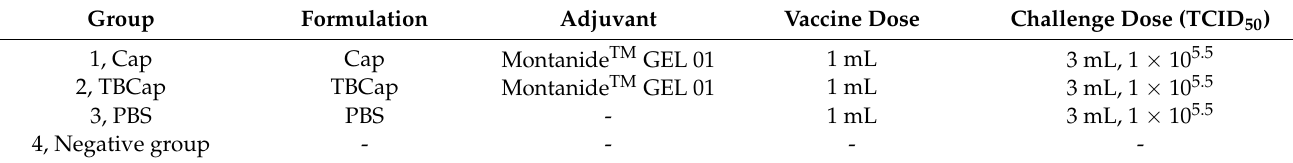
Table 3. The vaccination and challenge status of experimental piglets.